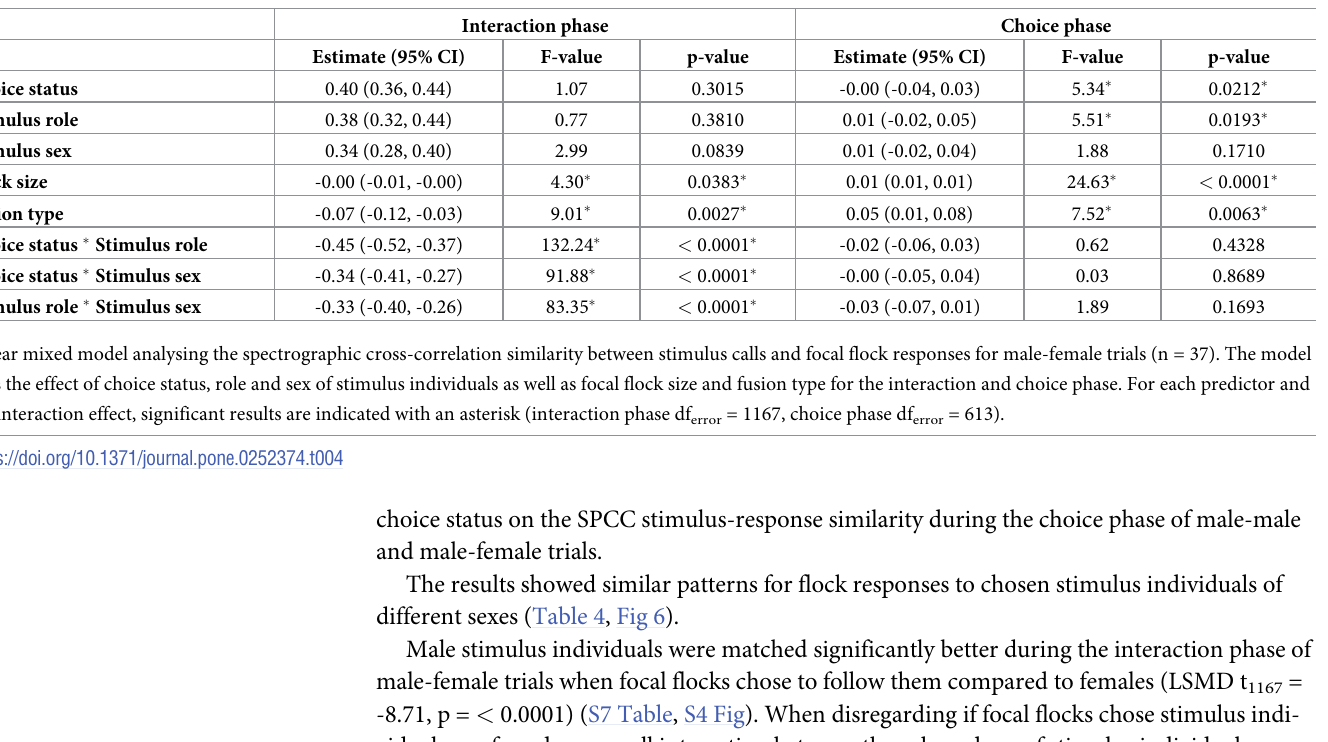
Table 4. Stimulus-response similarity results for male-female trials.